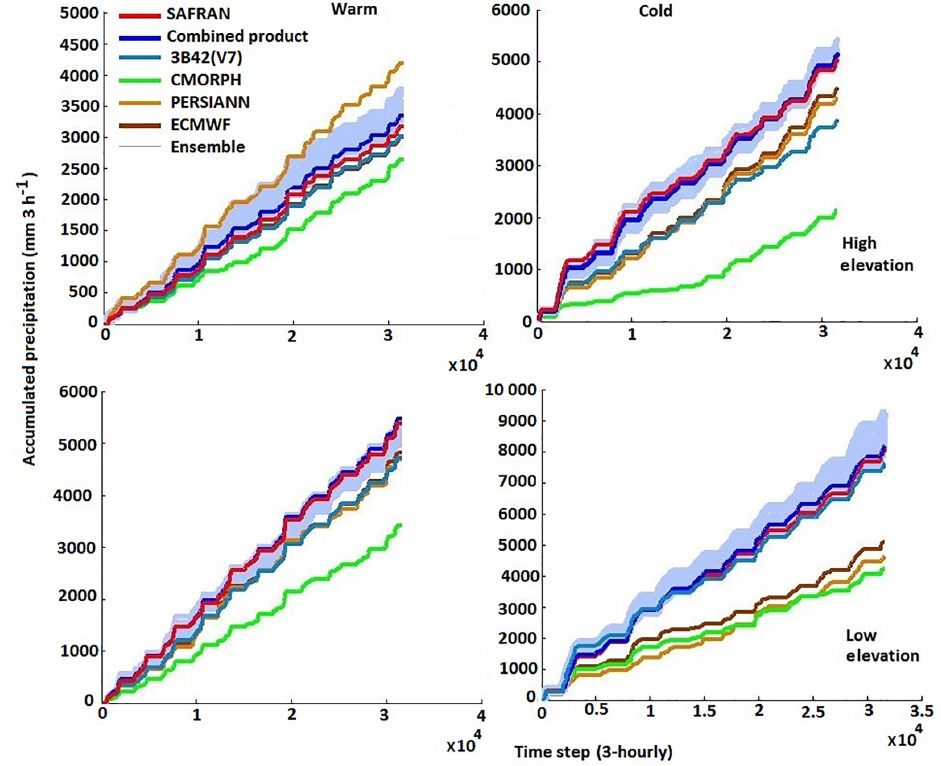
Figure 4. Time series of cumulative rainfall of CMORPH, PERSIANN, 3B42 (V7), reanalysis rainfall, and QRF ensemble (blue envelope) for warm and cold seasons.